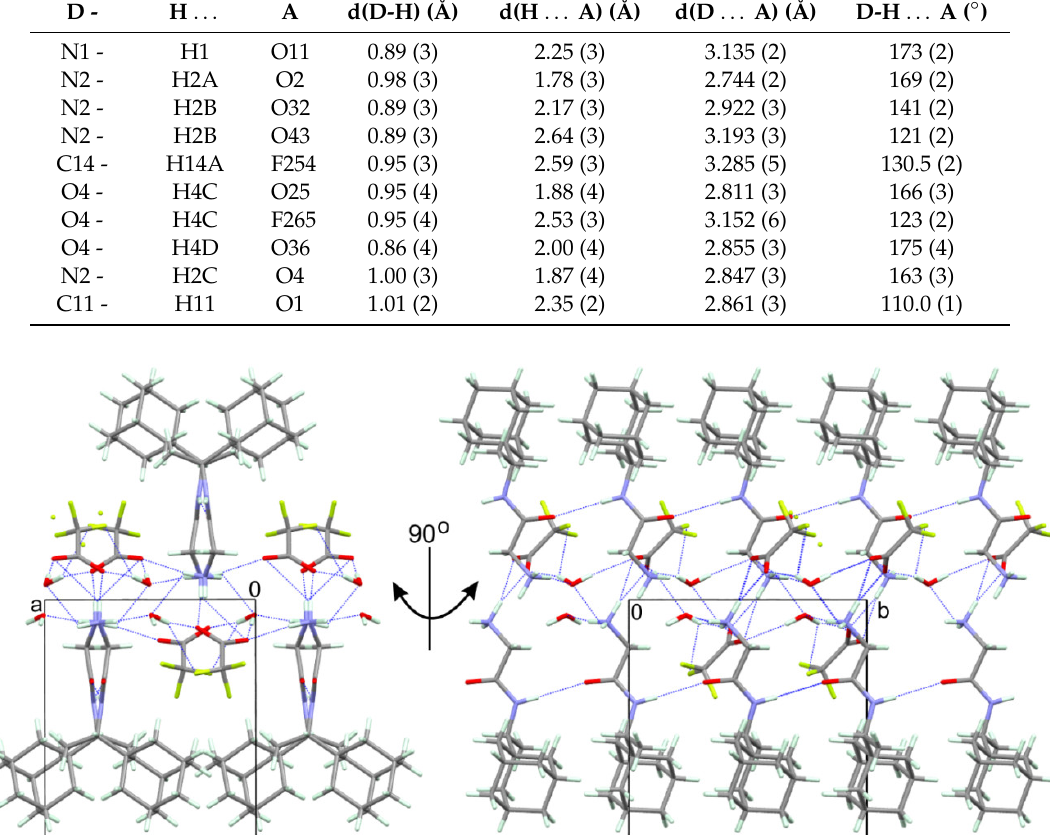
Figure 7. Oak Ridge Thermal Ellipsoid Plot (ORTEP) diagram of the glycyl-rimantadine ( 4b ) molecule present in the asymmetric unit along with employed numbering scheme; adenosine diphosphates (ADPs) are at the 50% displacement probability level while hydrogen atoms are shown as spheres with arbitrary radii. Table 5. Hydrogen bonds geometry (Å, °) for glycyl-rimantadine ( 4b ).